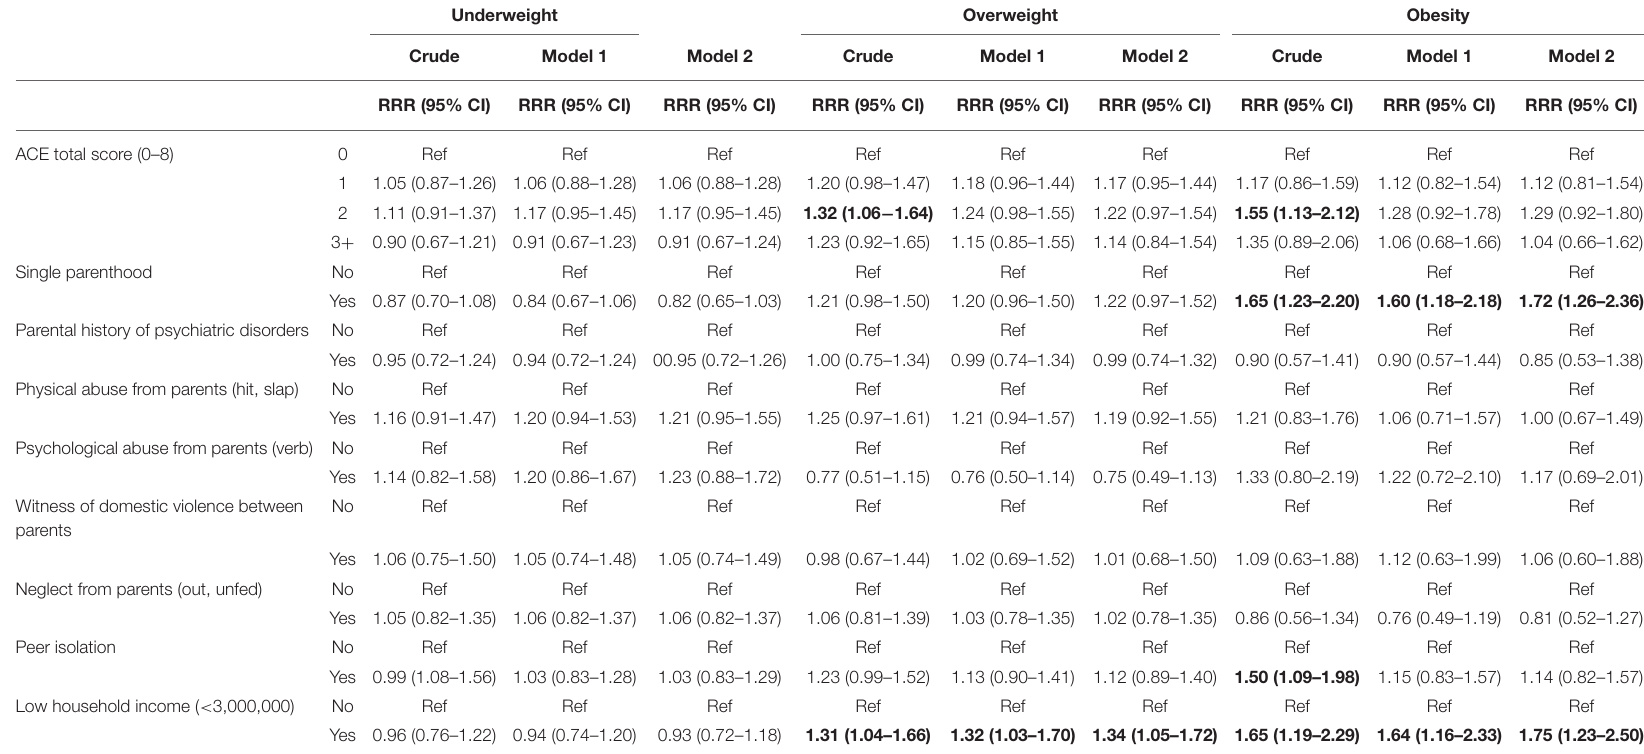
TABLE 2 | Results of multinomial logistic regression to examine the associations between ACEs and BMI ( N =